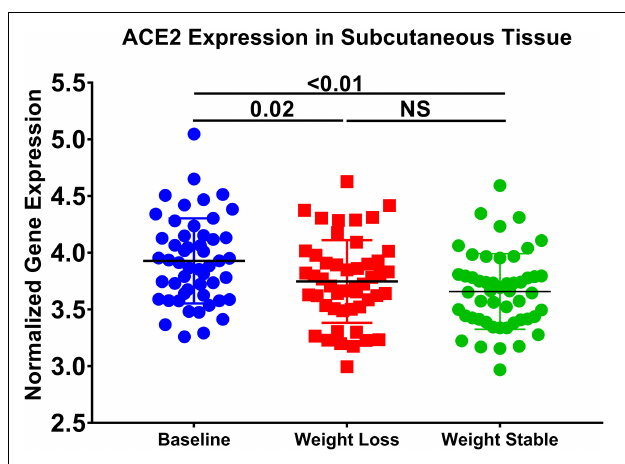
FIGURE 8 | ACE2 expression is decreased in subcutaneous adipose tissue after weight loss. The following publicly available transcriptomic dataset (GSE77962) was explored (25 males; BMI: 28–35 kg/m 2 ), and 28 females (BMI: 28–35 kg/m 2 ) were placed on a very low-calorie diet for 5 weeks and a subsequent weight stable period for 4